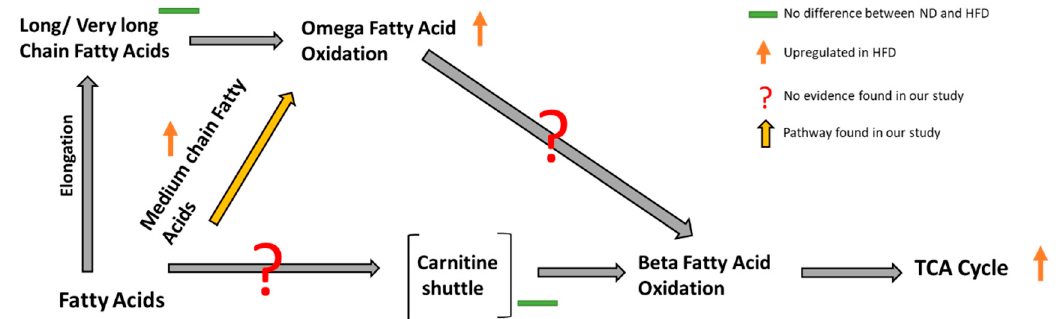
Figure 5. Elevation of omega fatty acid oxidation pathway and tricarboxylic acid cycle in flies fed with high-fat diet: omega fatty acid oxidation is an alternative pathway for fatty acid oxidation, which is increased in flies on HFD while there is no upregulation of more common beta fatty acid oxidation pathway.